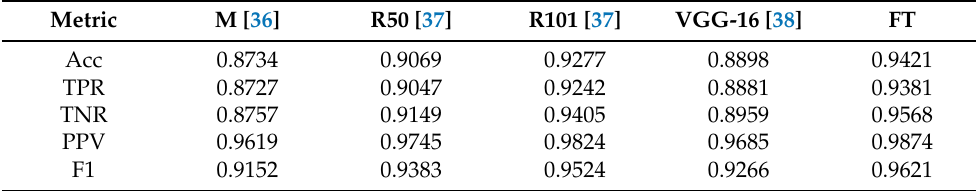
Table 6. Performance comparison on the BIOMISA dataset.